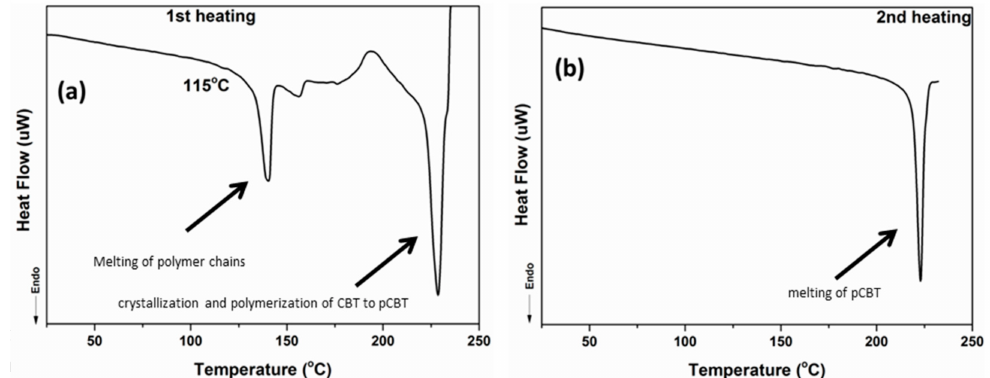
Figure 2. Di ff erential scanning calorimetry (DSC) curves for melting cyclic butylene terephthalate (CBT) polymer: ( a ) first heating; and ( b ) second